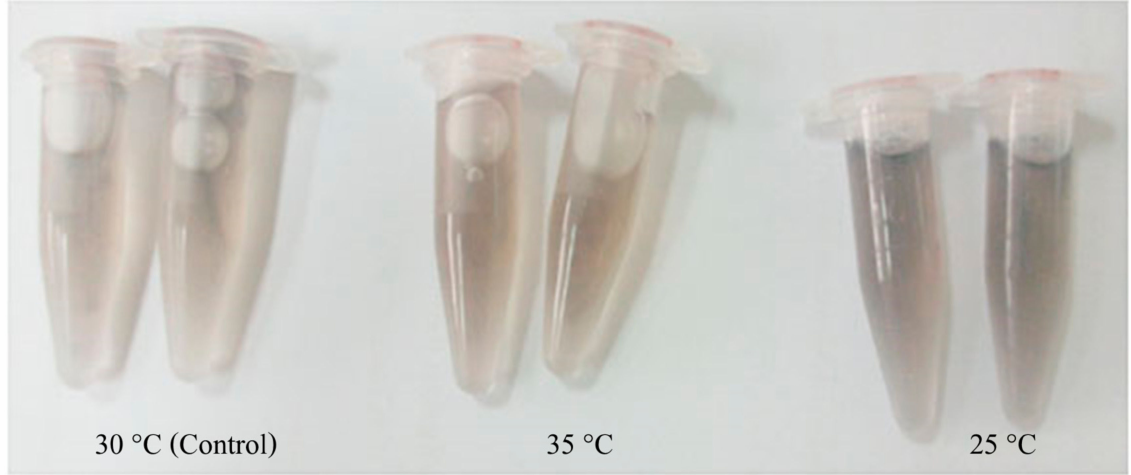
Figure 10. The colors of prawn hemolymph under different temperature inductions.